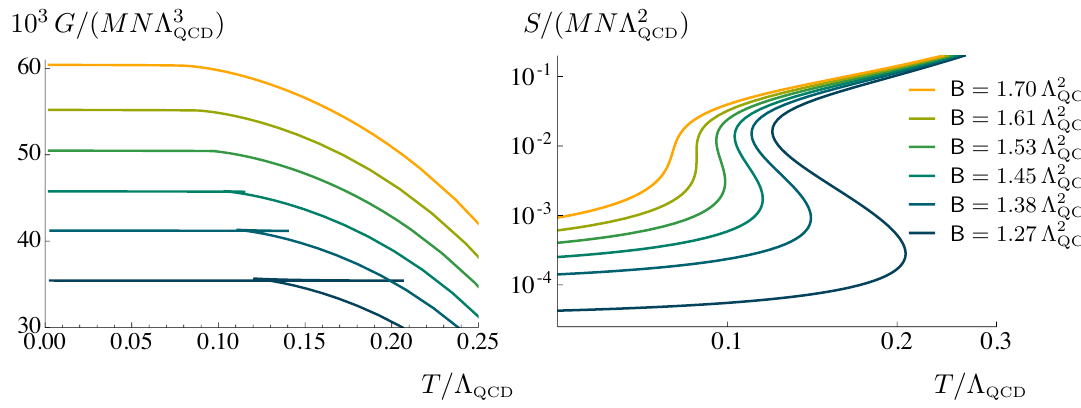
Figure 9. Left : free-energy density as a function of temperature for different values of B in the vicinity of the critical point, with the magnetic field increasing from bottom to top. The swallowtail is lost in the uppermost curves, which have B ≥ B . Right : log-log plot of the entropy density critical as a function of temperature for the same values of the magnetic field. When the swallowtail shape disappears in the curves for the free energy, above B , the phase transition becomes second critical order at the critical point and a smooth crossover for even larger values of B